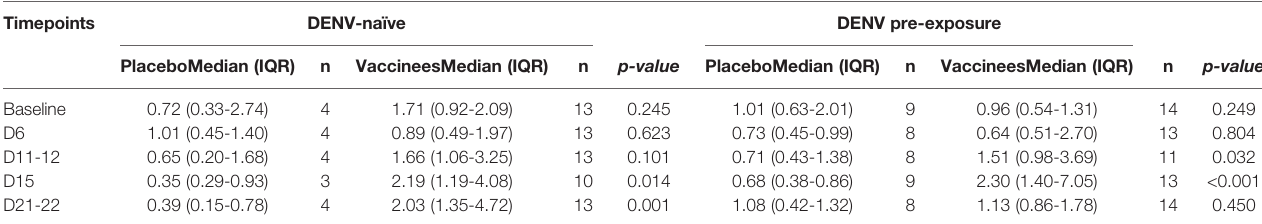
TABLE 2 | Plasmablast percentage in participants allocated to placebo and Butantan-DV vaccinees according to the pre-vaccination DENV serostatus. Timepoints DENV-naïve DENV pre-exposure